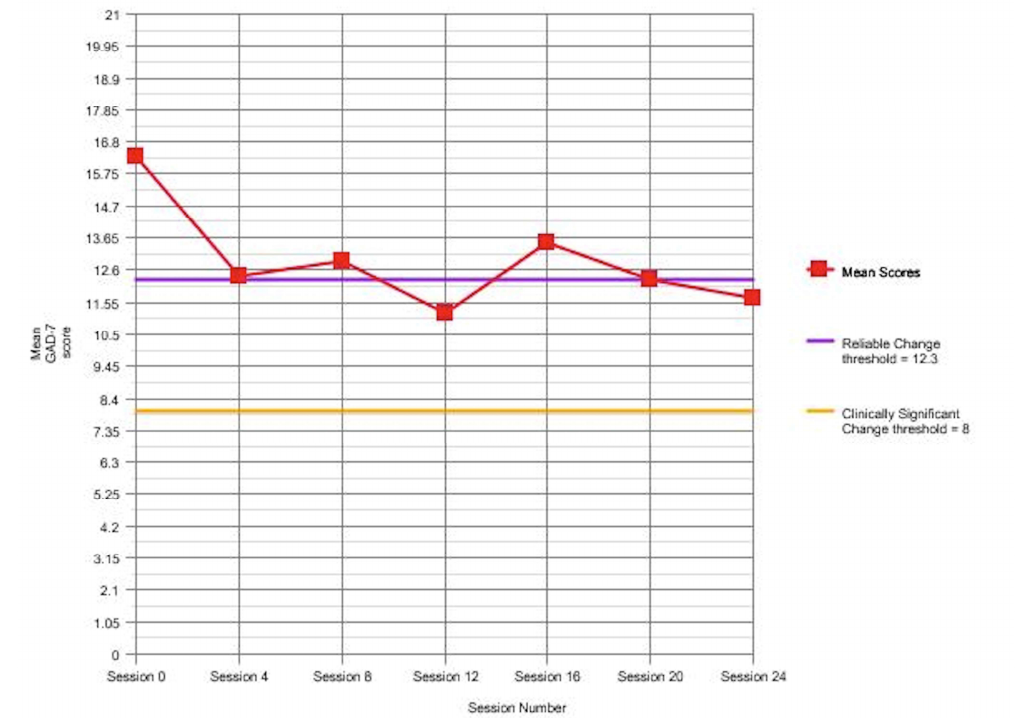
Figure 6: Mean GAD-7 score: 7 short-term